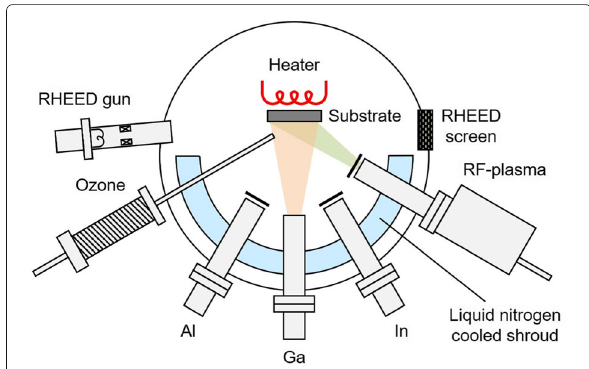
Fig. 4 Schematic of MBE machine with both O 3 inlet and O-plasma cell for β -Ga 2 O 3 epitaxial growth